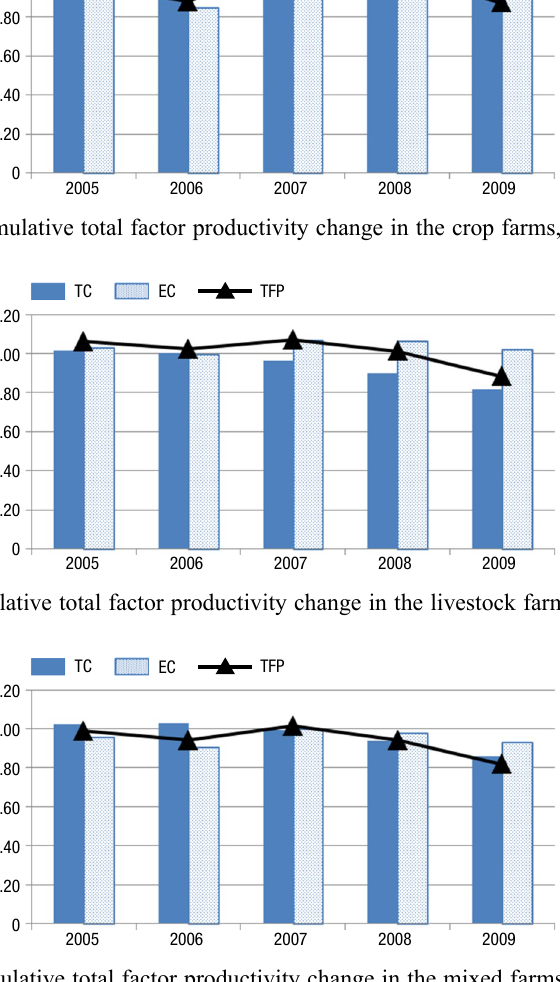
Fig. 5. The cumulative total factor productivity change in the mixed farms,